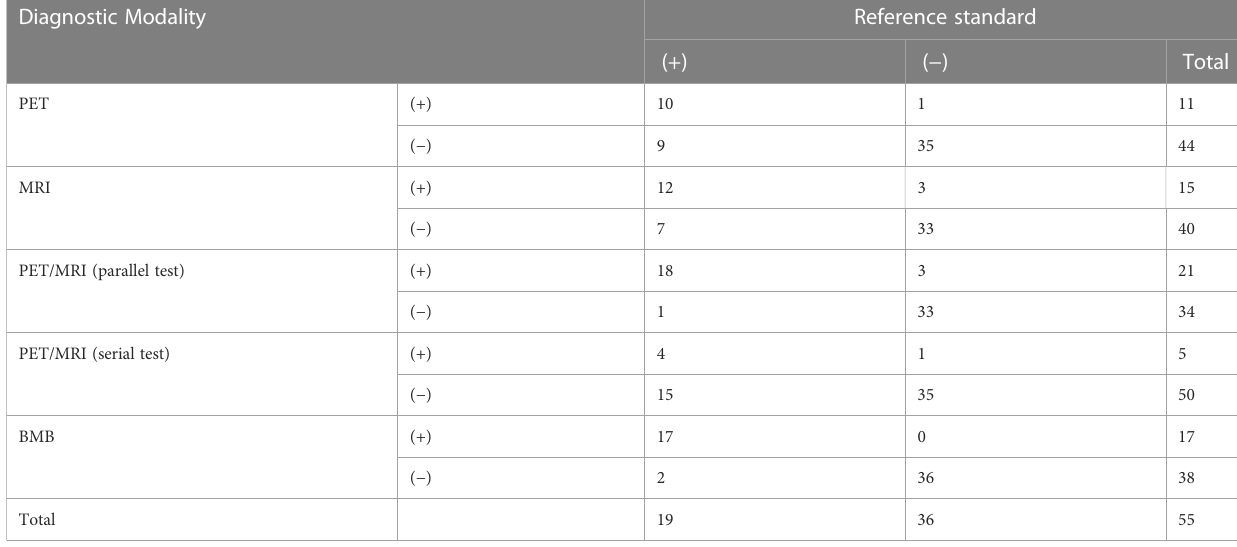
TABLE 2 Comparison of PET, MRI, PET/MRI, and BMB results with the reference standard for detecting bone marrow involvement. Diagnostic